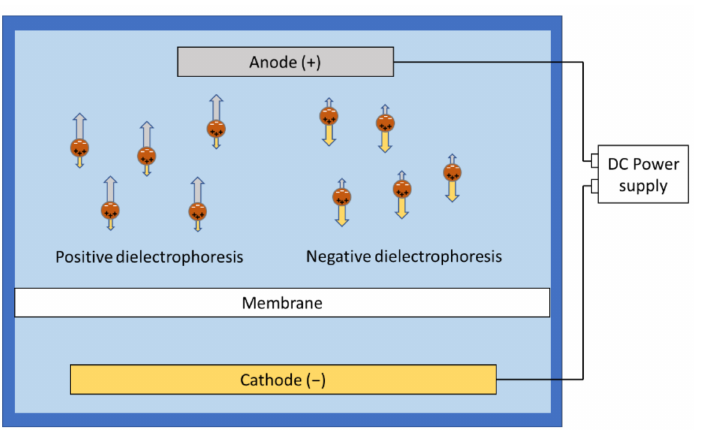
Figure 6. Dielectrophoresis inducing unbalanced forces on the particles/dipoles under a non-uniform direct current